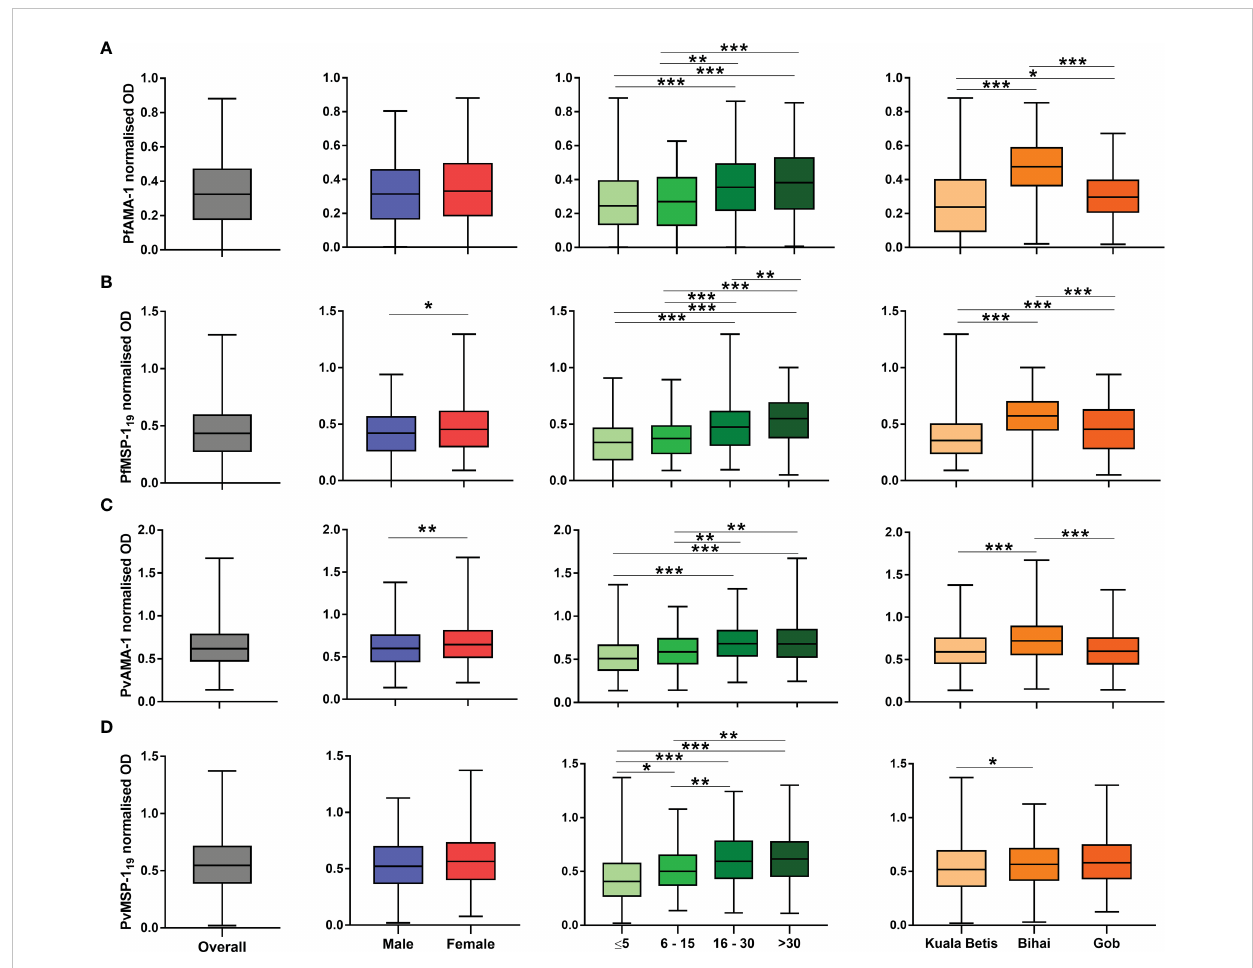
FIGURE 3 Distribution of antibody responses to P. falciparum and P. vivax antigens expressed as normalised optical density (OD) values. Plots are divided by antigen: (A) PfAMA-1, (B) PfMSP-1 19 , (C) PvAMA-1, and (D) PvMSP-1 19 . The interquartile range (IQR, 25 – 75th percentile) is represented in a box plot with the median OD value shown as a line within the box. Antibody levels between categories were compared using the Mann – Whitney U test or the Kruskal – Wallis test with Dunn ’ s multiple comparison post-hoc tests.* p < 0.05; ** p < 0.01; *** p <